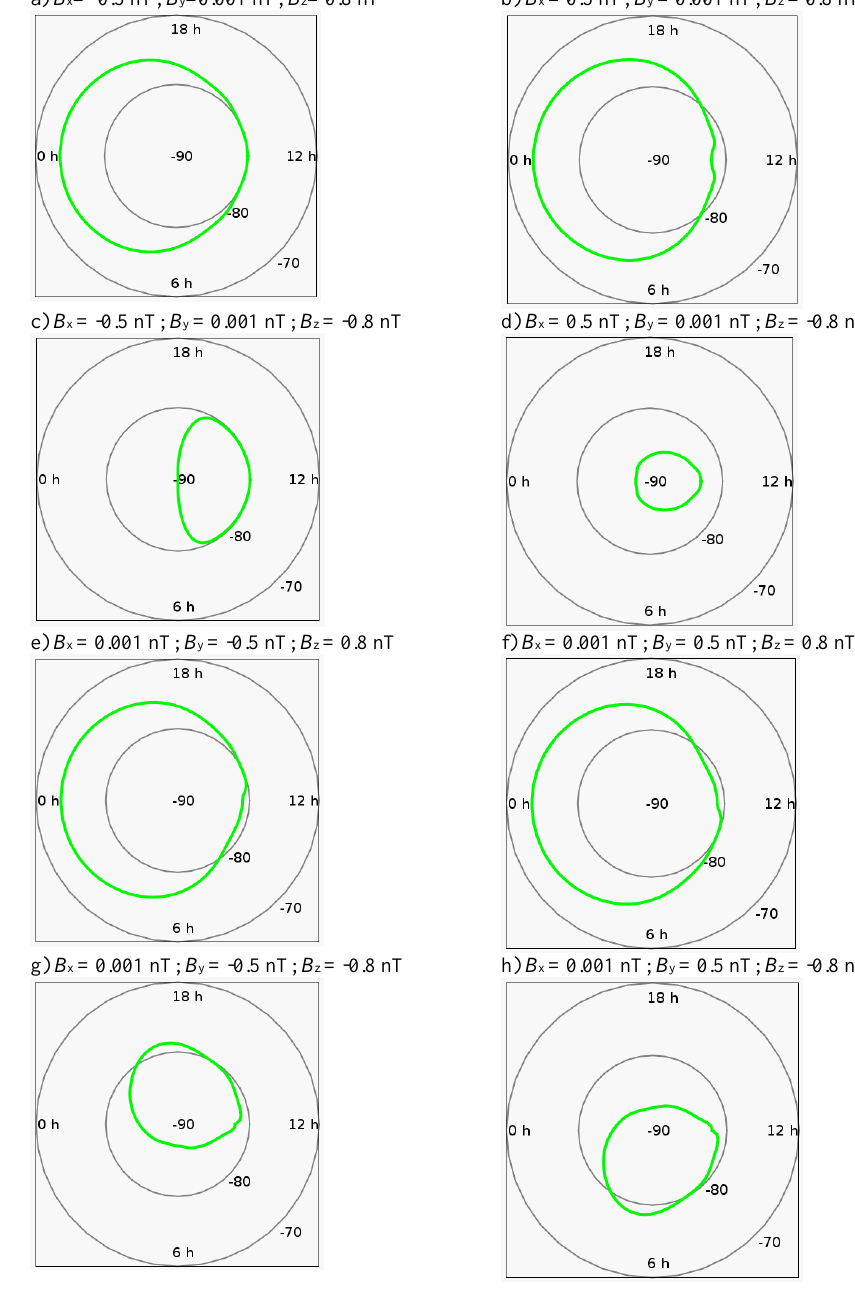
Fig. 3. Plots showing the effect of each KSM IMF component on the ionospheric open field line region in the Southern Hemisphere, where noon is on the right of each plot, and dusk at the top. Latitude circles are shown with 10 ◦ steps, while green curves show the calculated open-closed field line boundary. The corresponding IMF vector is given at the top of each plot, and we have taken the penetration coefficient k s =0.8. Plots (a) and (b) show the influence of B x for B z > 0, (c) and (d) the influence of B x for B z < 0, (e) and (f) the influence of B y for B z > 0, and (g) and (h) the influence of B y for B z < 0.